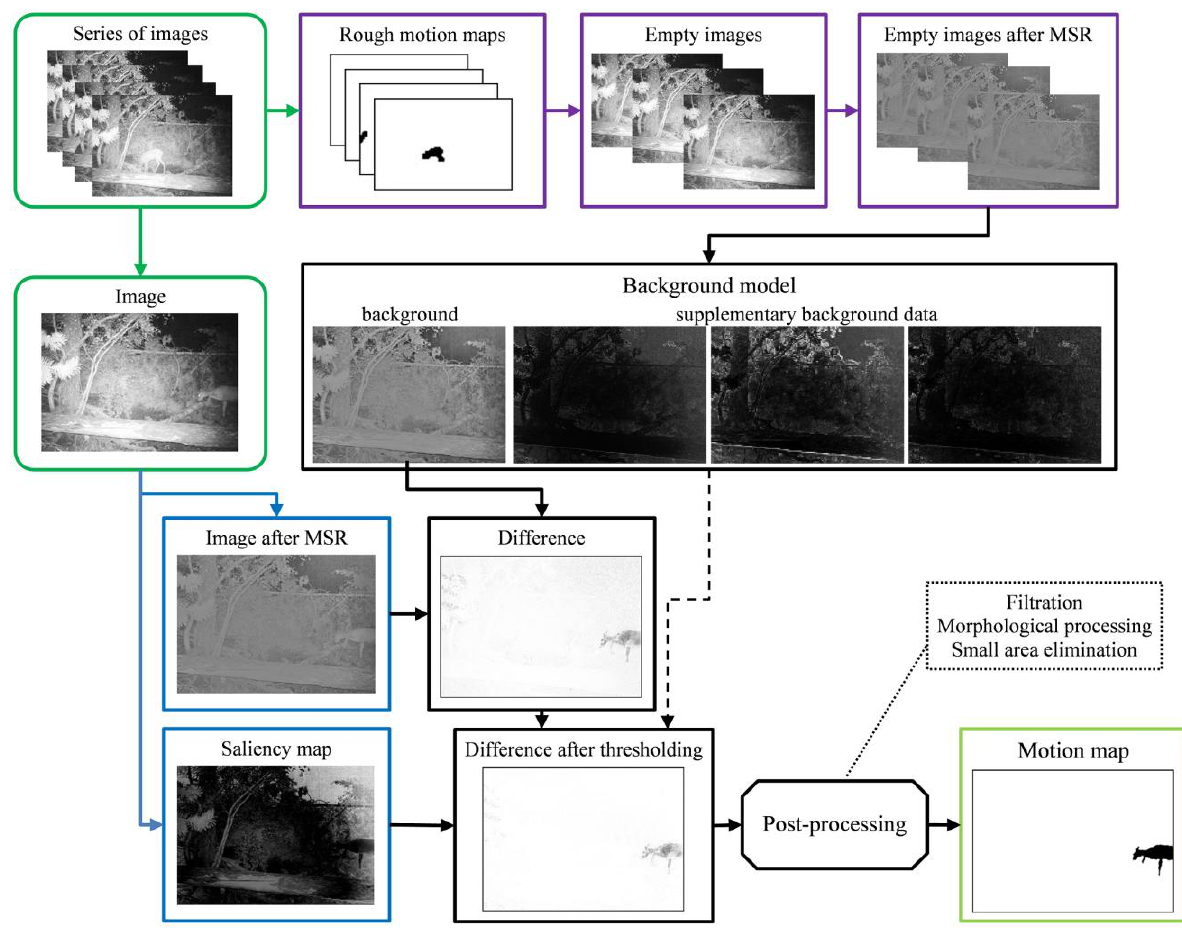
Figure 1. A scheme of the proposed method. Motion maps and differences are